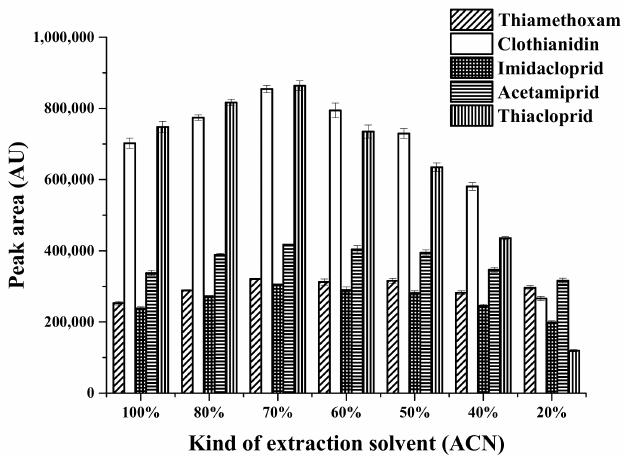
Figure 4. Effect of extraction solvent on the extraction efficiency, using 30 mg MMT sorbent, sample volume of 13 mL, and 0.03 g Na 2 SO 4 . ACN: